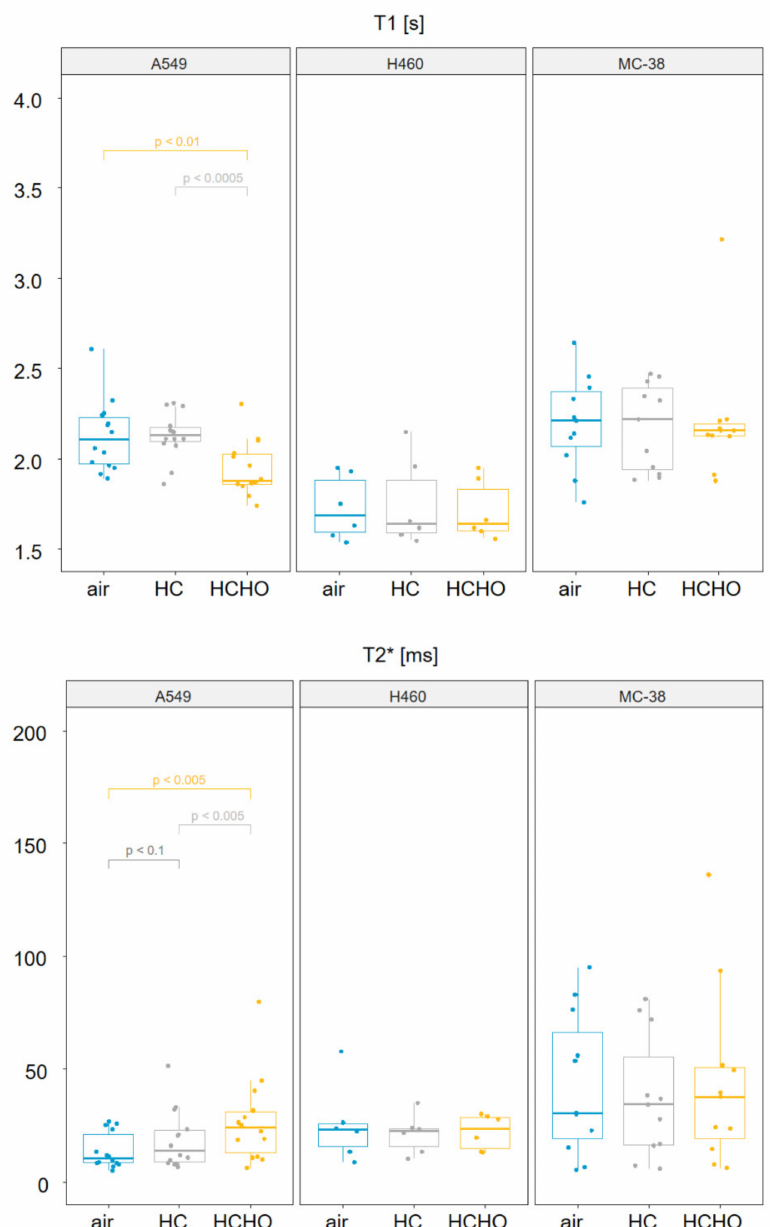
Figure 2. Quantitative T1 and T2* changes in response to hypercapnic (HC, grey) and hypercapnic- hyperoxic (HCHO, orange) gas challenge compared with medical air (blue), in A549, H460, and MC-38 grafts. In A549 grafts, T1 values significantly decreased in response to HCHO, but not to HC alone, as expected. T2* increased during HC, and even more so under HCHO. No significant change was revealed in either T1 or T2* in MC-38 or H460 grafts,